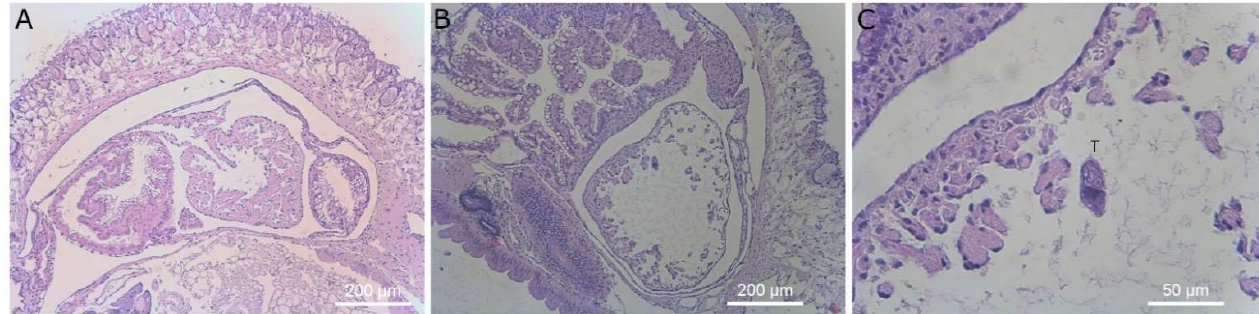
Figure 9. Histological sections of the pulmonary region. Image ( A ) shows the pulmonary region of a healthy control slug. Images ( B ) (×40 mag) and ( C ) (×400 mag) show a single ciliate in the heart and an enlarged chamber of the heart of a slug exposed to T. rostrata . Ciliates are marked with a “T” above the cell in panel ( C ).